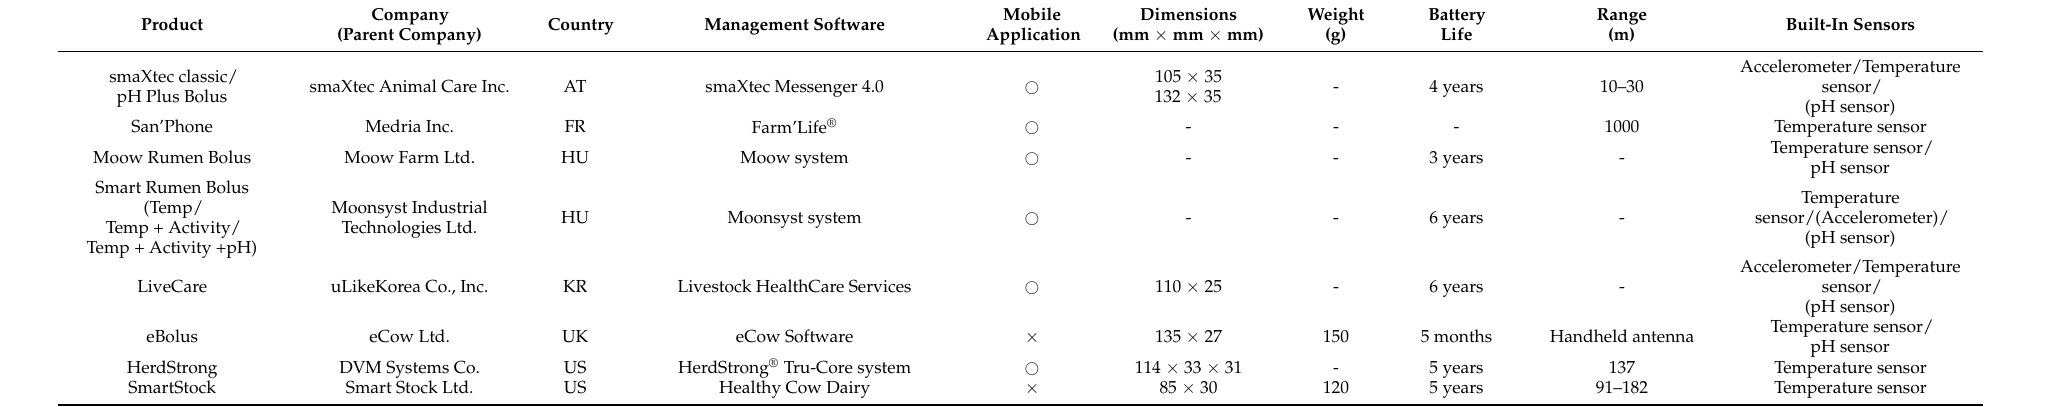
Table 5. Information about currently available rumen bolus type sensors.